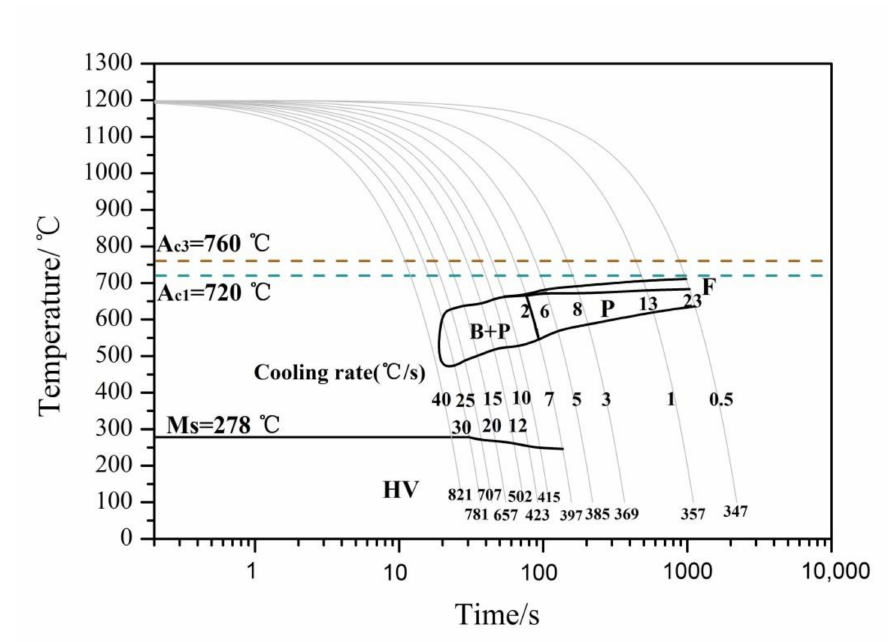
Figure 5. Continuous cooling transformation (CCT) diagram of powder-forged Fe-2.5Cu-C